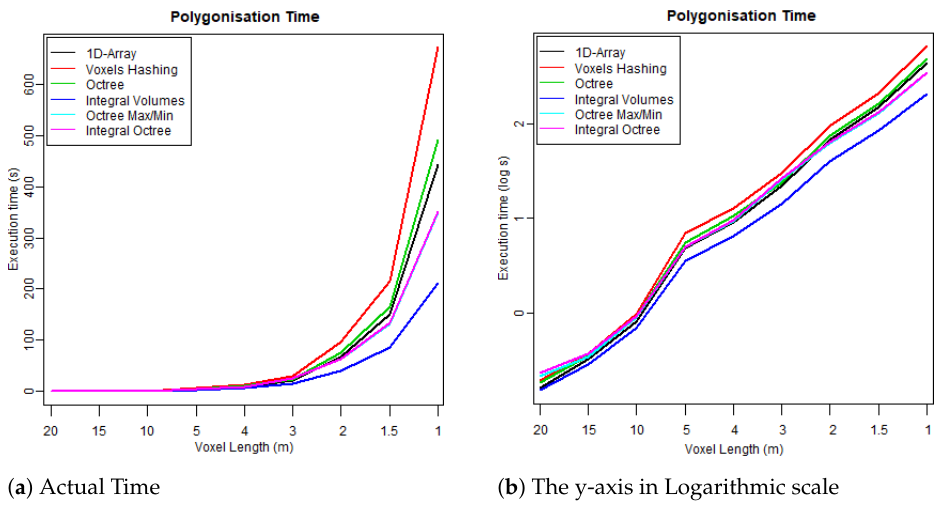
Figure 10. Time required to reconstruct the surface from the voxelised FW LiDAR data (Table 4).